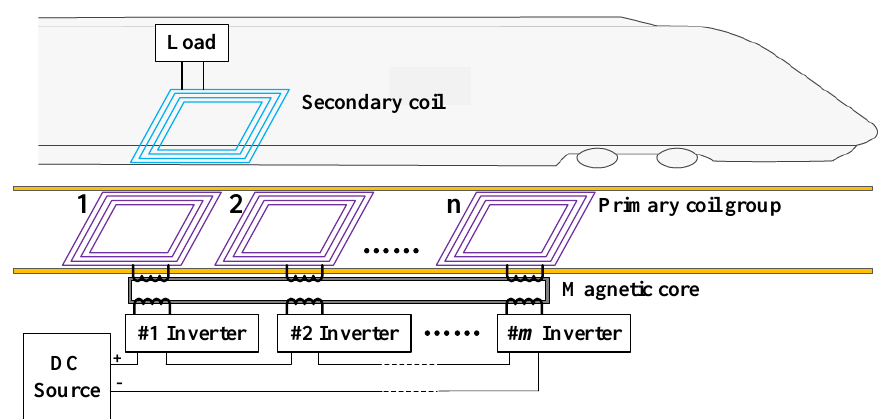
Figure 1. High-voltage anti-offset WPT system structure diagram.